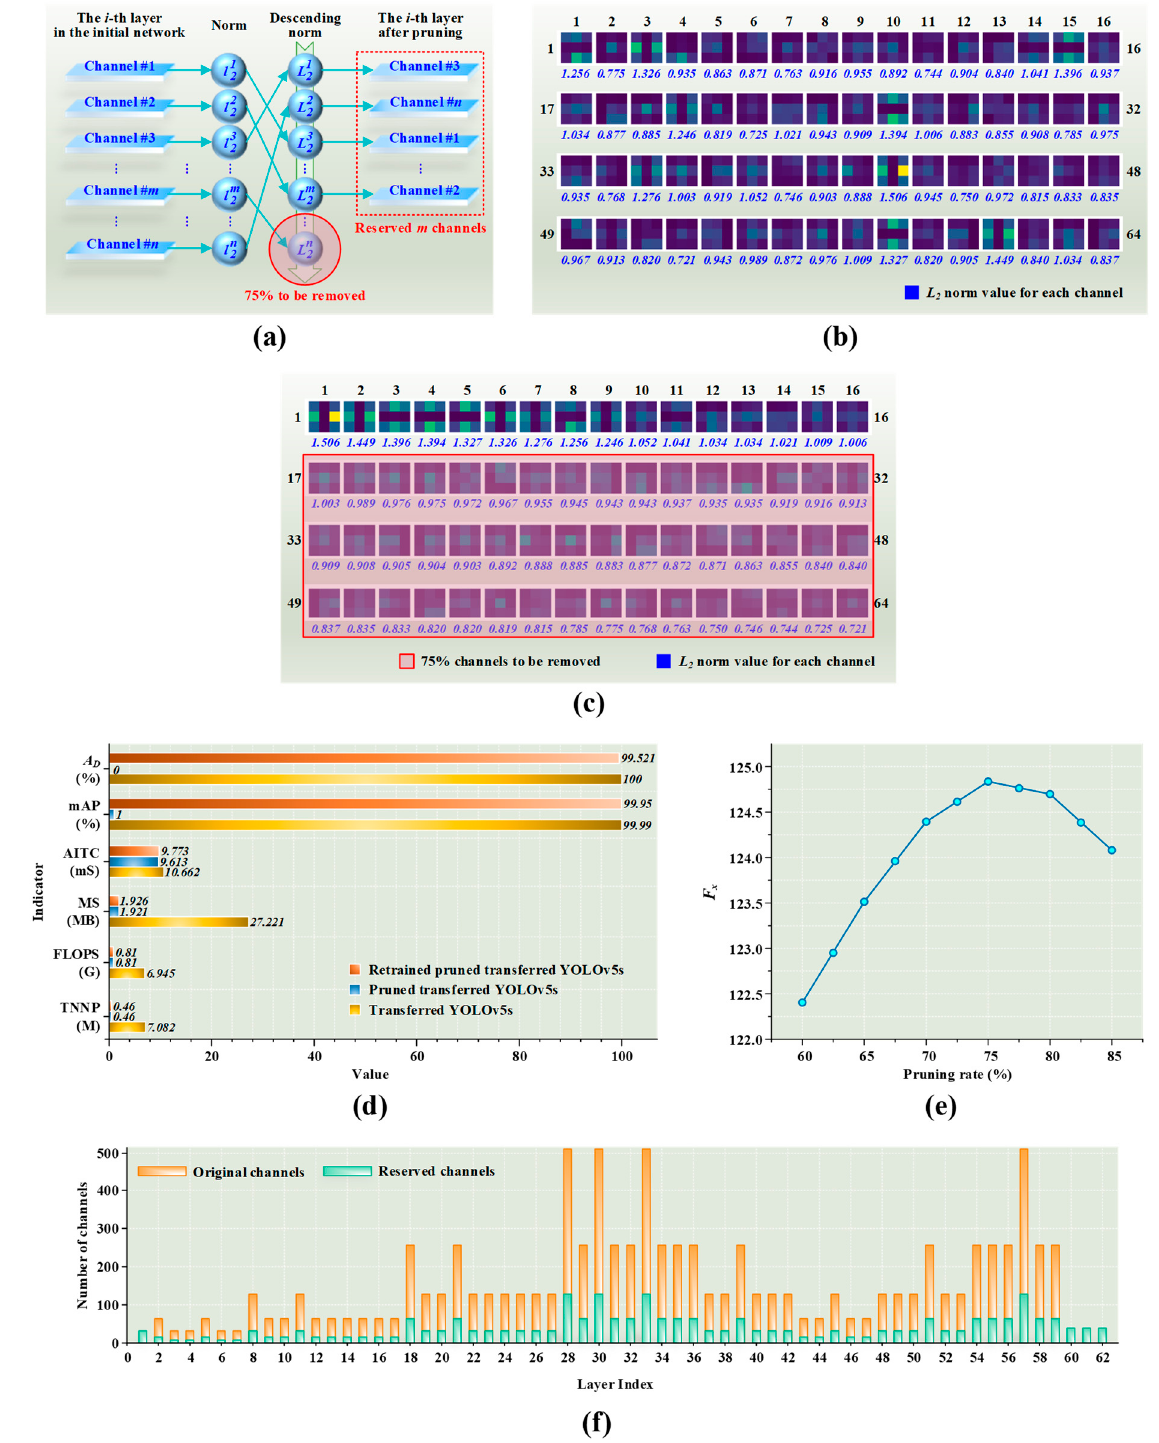
Figure 6. Results of network pruning in the transferred model: ( a ) our network pruning strategy; ( b ) the visualization for the initial output of the specific layer in our model; ( c ) the visualization for the channel removal in the specific layer under descending L 2 norm value; ( d ) influence on network pruning on the model performance; ( e ) the impact of different pruning rates on F x in the validating set; ( f ) changes in the number of channels before and after pruning.